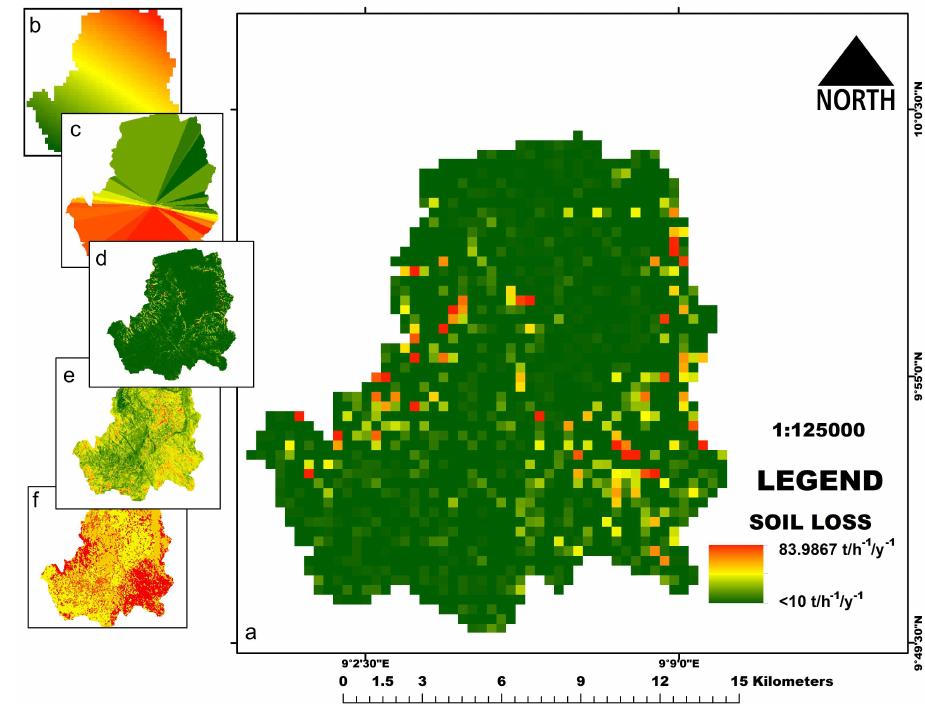
Figure 14. ( a ) The soil loss map; ( b ) R factor; ( c ) K factor; ( d ) LS factor; ( e ) C factor; ( f ) P factor. Table 2. An estimation of the annual soil loss